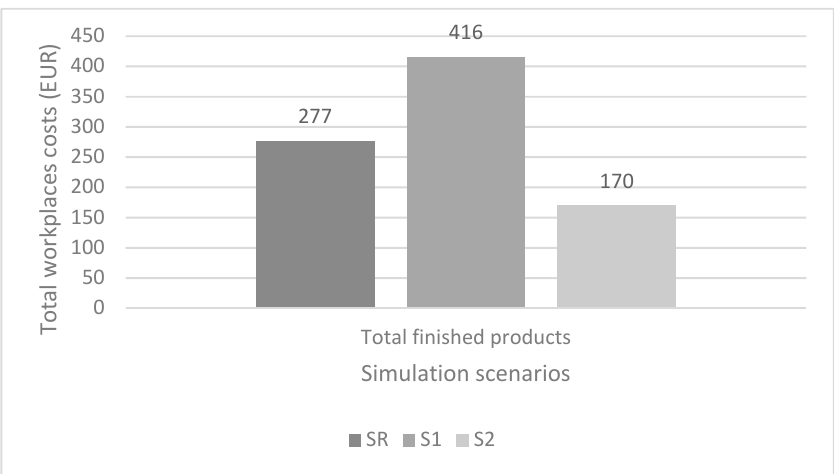
Figure 8. Total workplace costs simulation scenarios’ comparison.